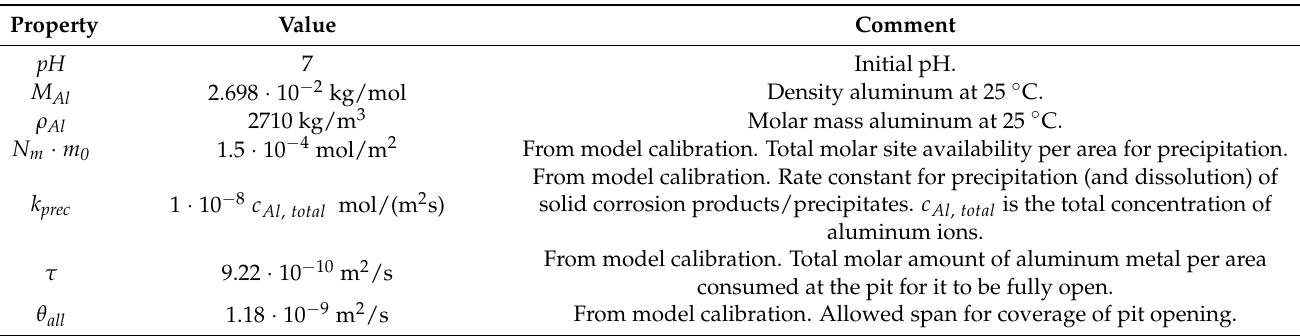
Table 3. Physical properties of liquids and